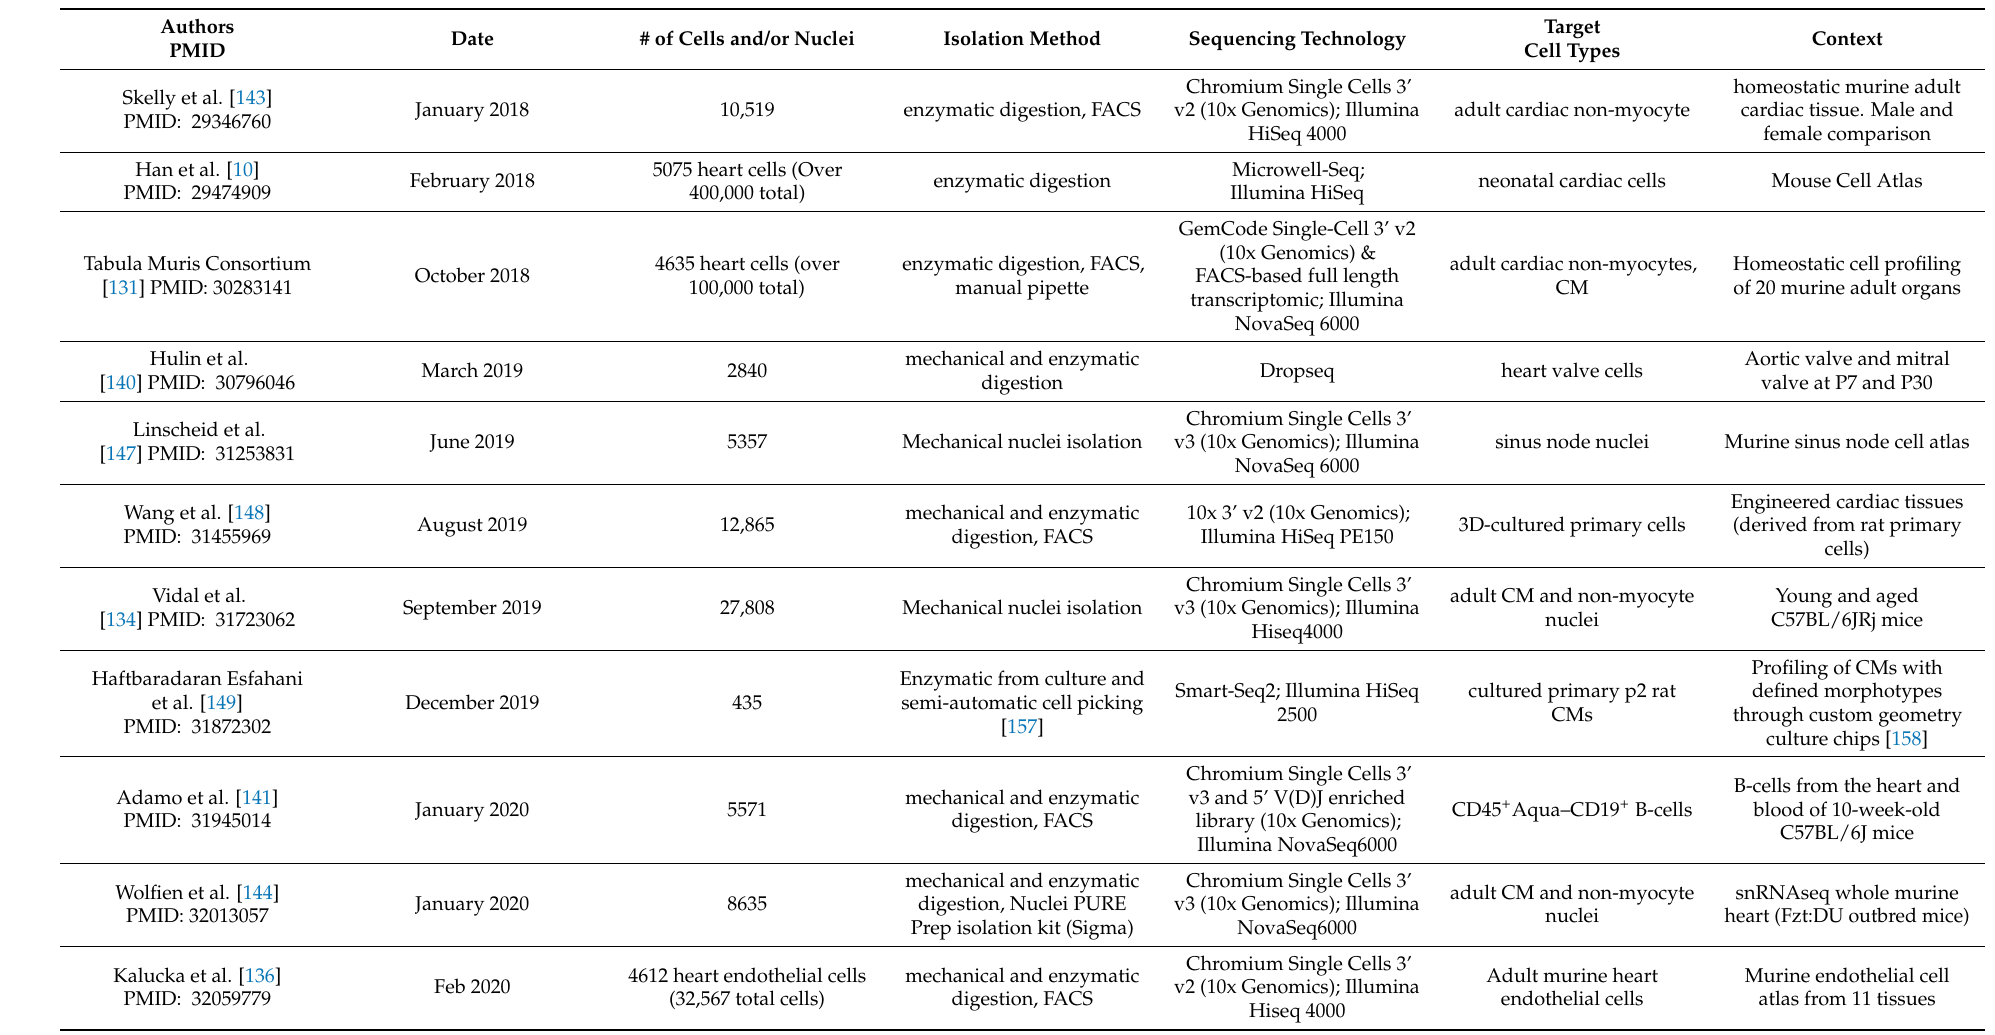
Table 6. Adult heart single-cell